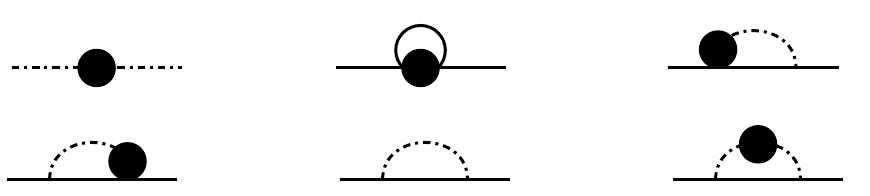
Figure 7 . Diagrams contributing to the large distance limit of the two-point functions at LO in √ λ and at NLO in 1 /N . The solid black bubbles are the dressed bubbles defined in figure 6.